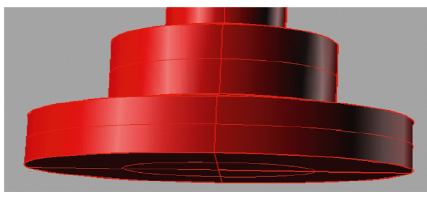
Figure 2: Flat face plug.